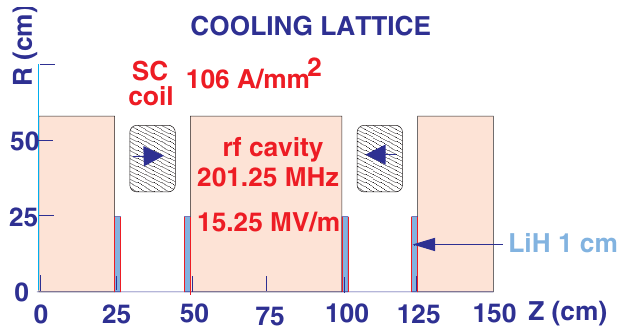
FIG. 12. (Color) Schematic of one cell of the cooling section.